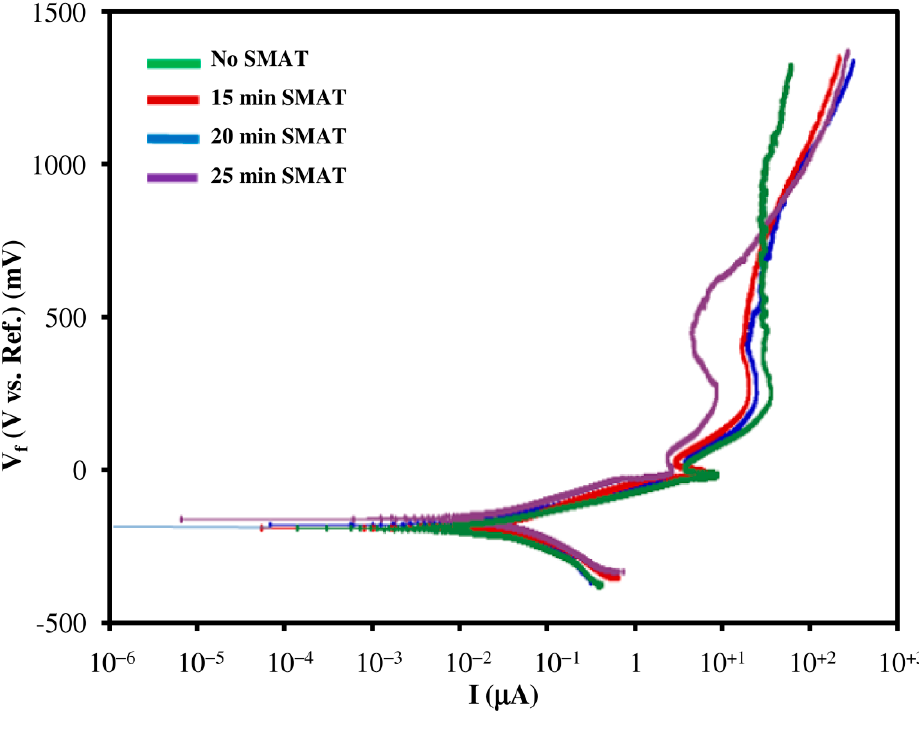
Figure 8. Potentiodynamic polarization curves of undeformed and SMAT deformed samples.